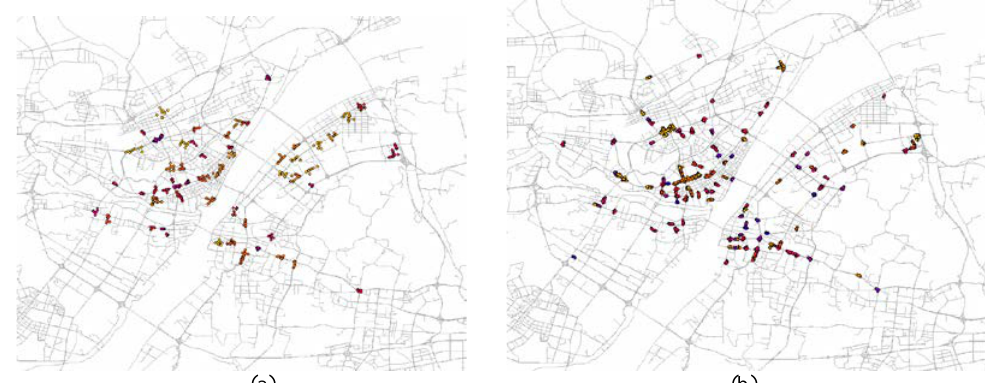
Figure 7. Comparision result between spatiotemporal data field and ST-DBSCAN. (a) The cluster result of spatiotemporal data field, (b) the cluster result of